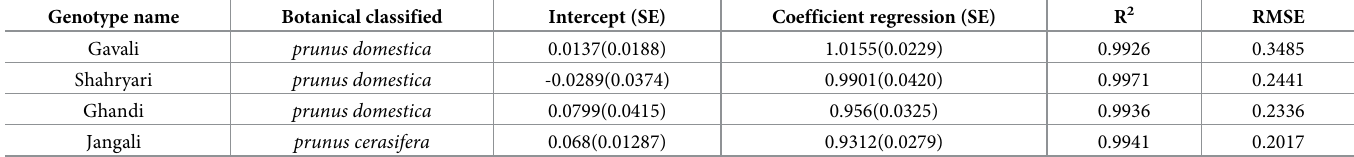
Table 4. Interestingly, the selected model in 2019 was not only able to predict LA for the same plum accession, but also succeeded in predicting the LA in large size populations for the other three Table 4. Validation of “LA = 0.6871LW + 0.0074” model for estimation of LA of three greengage genotypes with local names Gavali, Ghandi and Shahryari, and a myrobalan plum with the local name of Jangali, recorded in